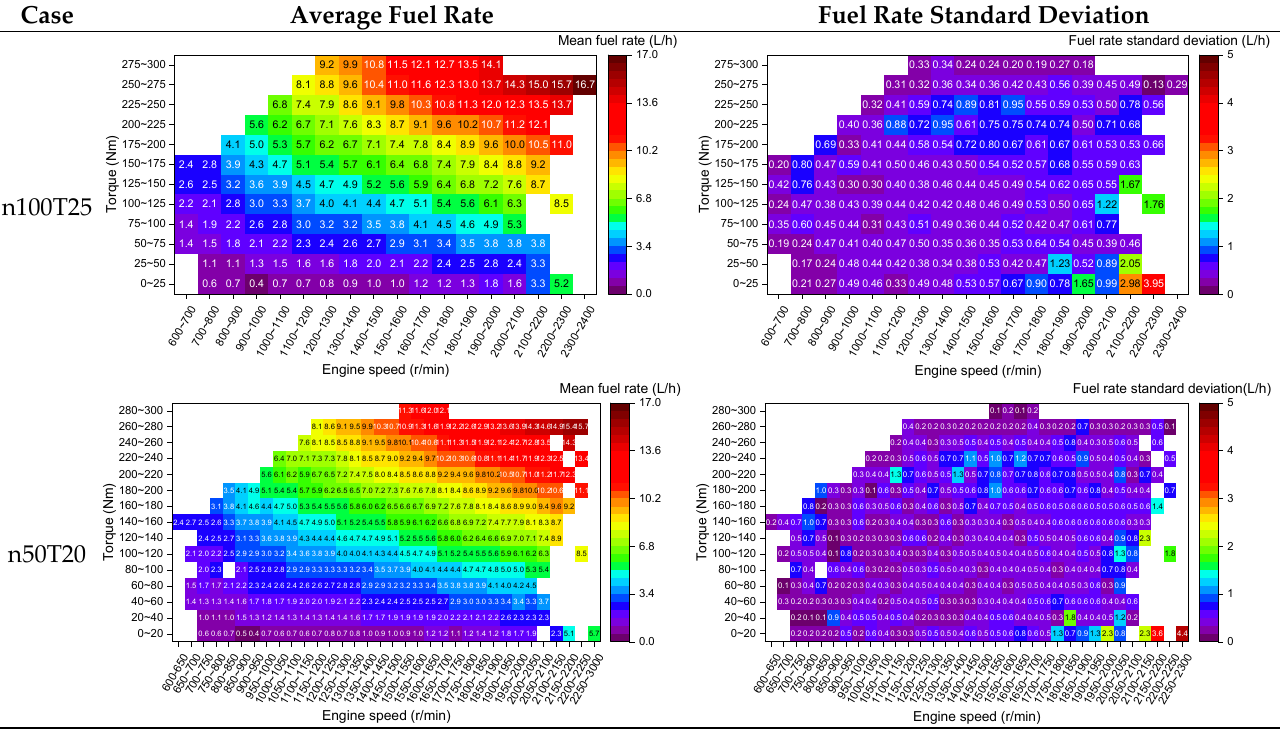
Figure 3. Binning of the fuel rate (vehicle one).